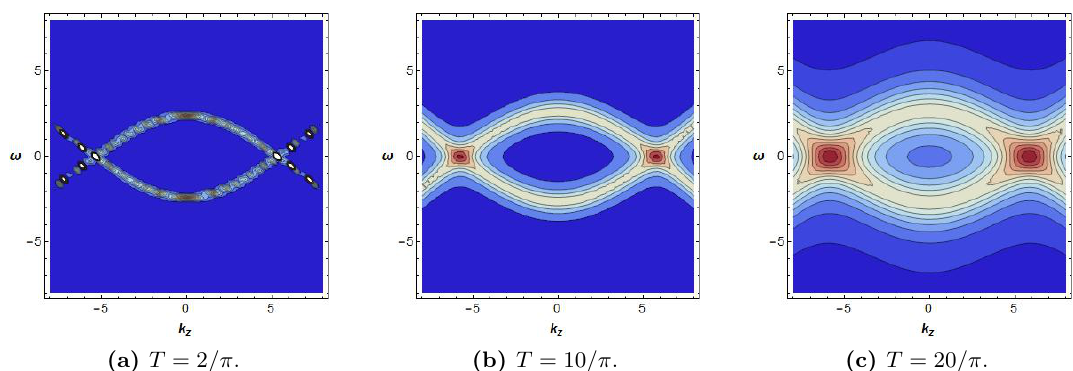
p b 2 (cid:0) M 2 .